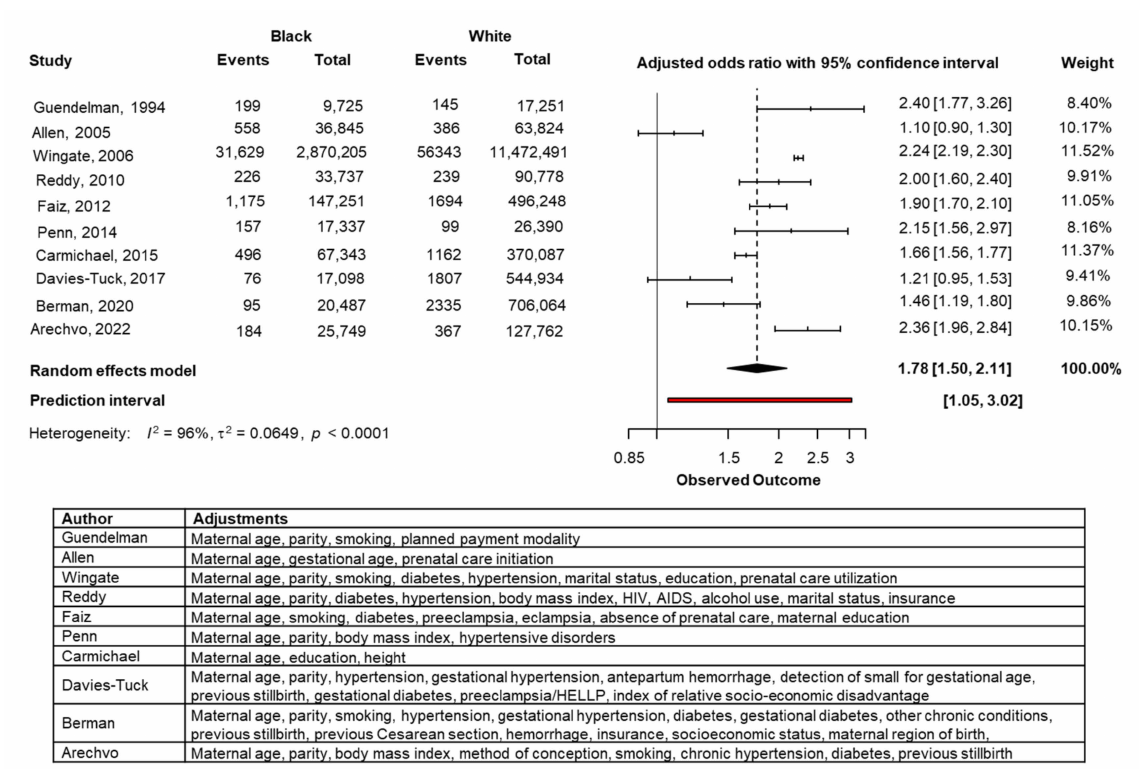
Figure 2. Forest plots of risk ratio for stillbirth in Black women compared with White women with 95% confidence intervals (CI) and weighted pooled summary statistics using a bivariate random-effects model.